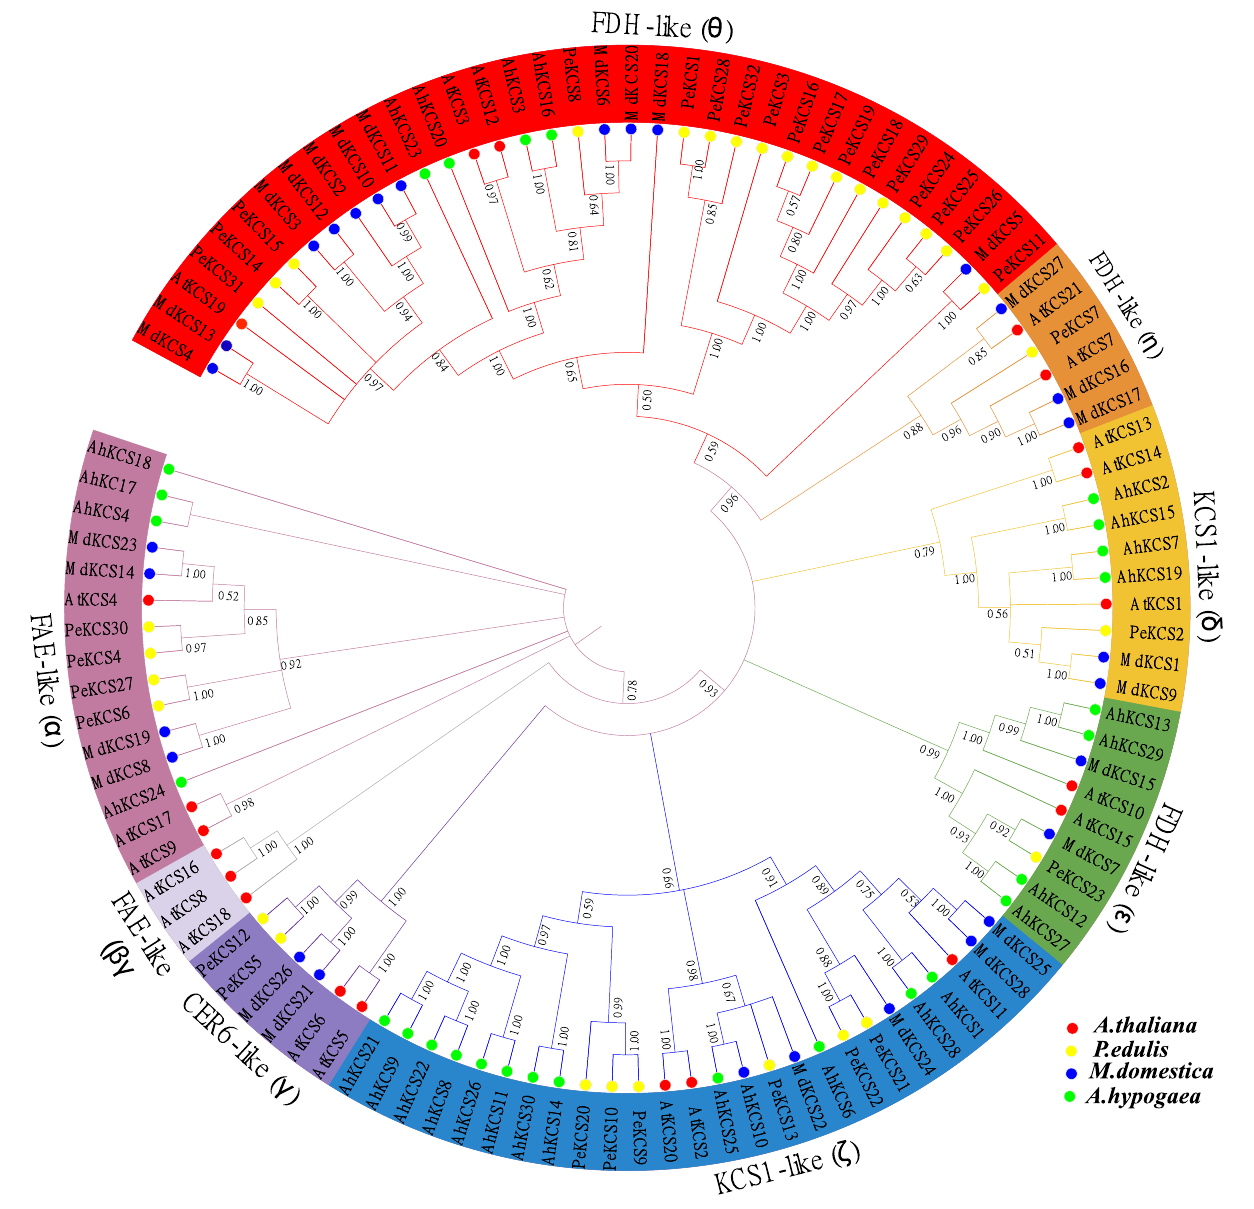
FIGURE 2 | An unrooted neighbor-joining (NJ) phylogenetic tree based on the amino acid sequences alignment among A. thaliana, P. edulis, M. domestica, and A. hypogaea KCS sequences with 1000 bootstraps. All the KCS members were divided into 8 groups and presented in different colors. The protein sequences of AtKCS, PeKCS, MdKCS, and AhKCS are represented by red, yellow, blue, and green color circles